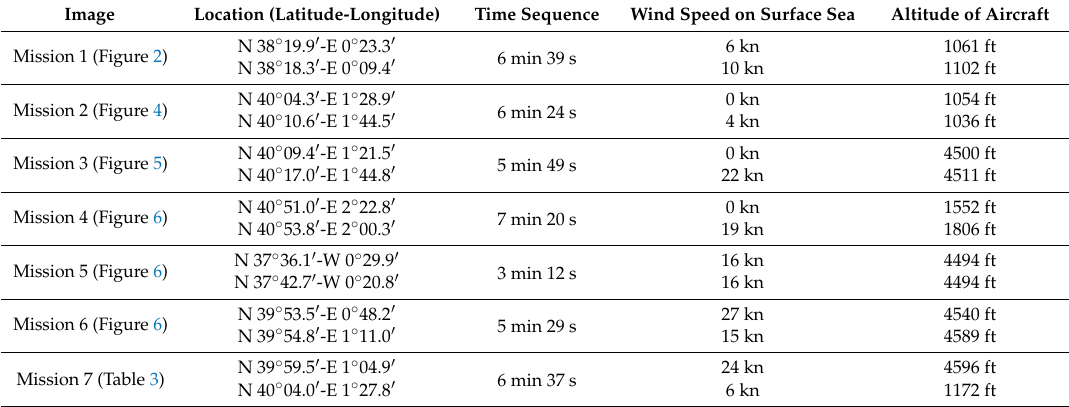
Table 1. Information of SLAR dataset with final and initial data obtained on missions, respectively.